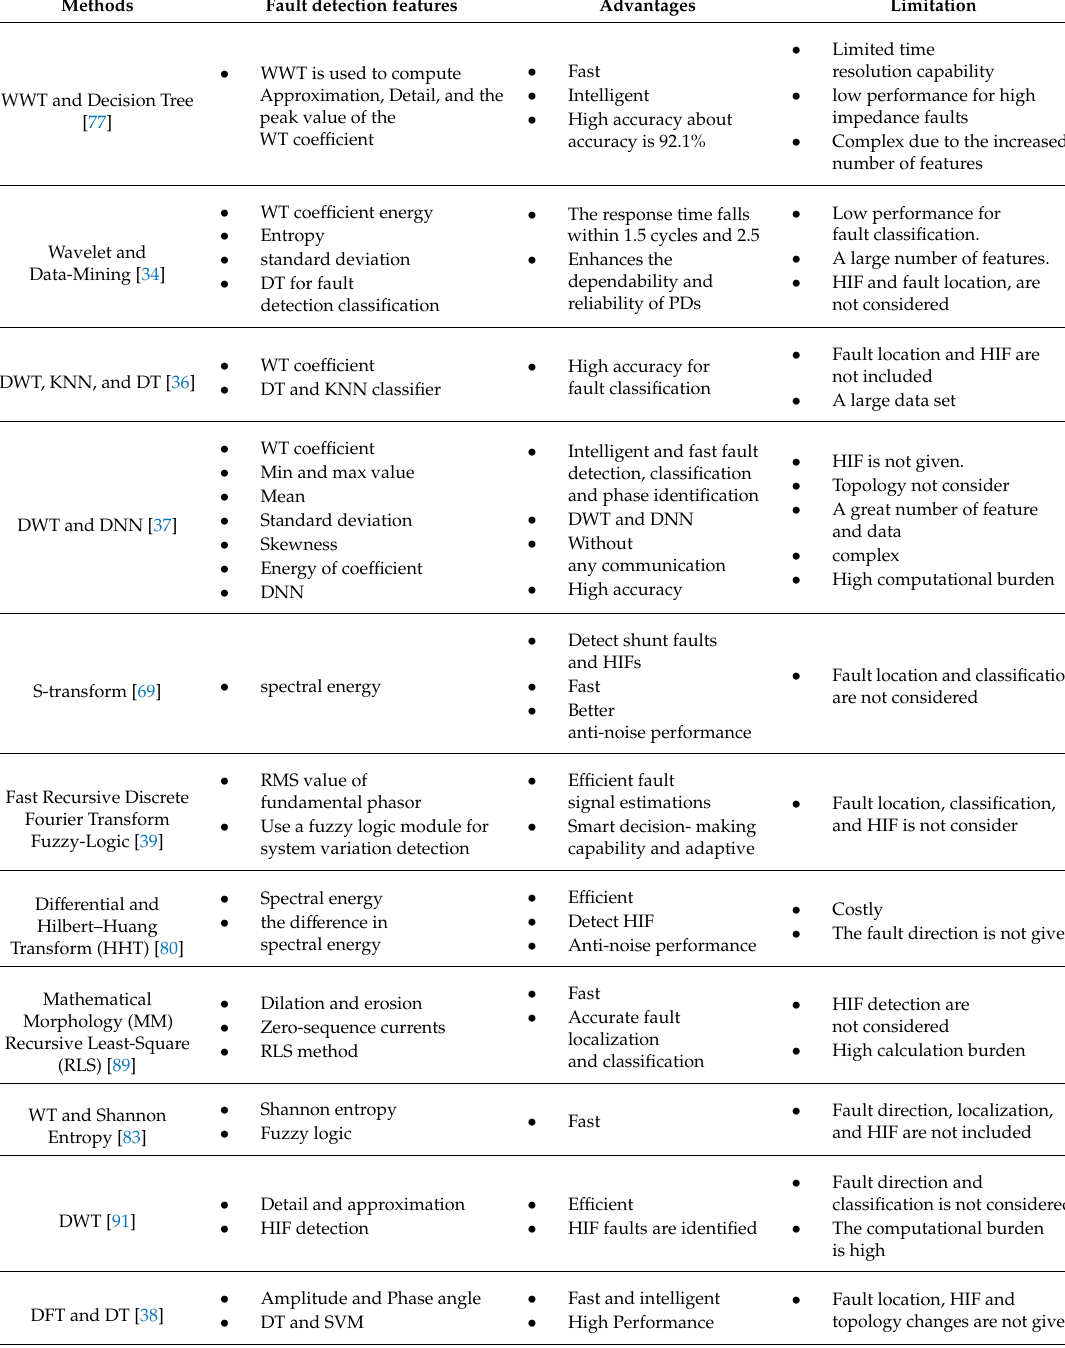
Table 2. Fault detection and protection scheme using signal processing based